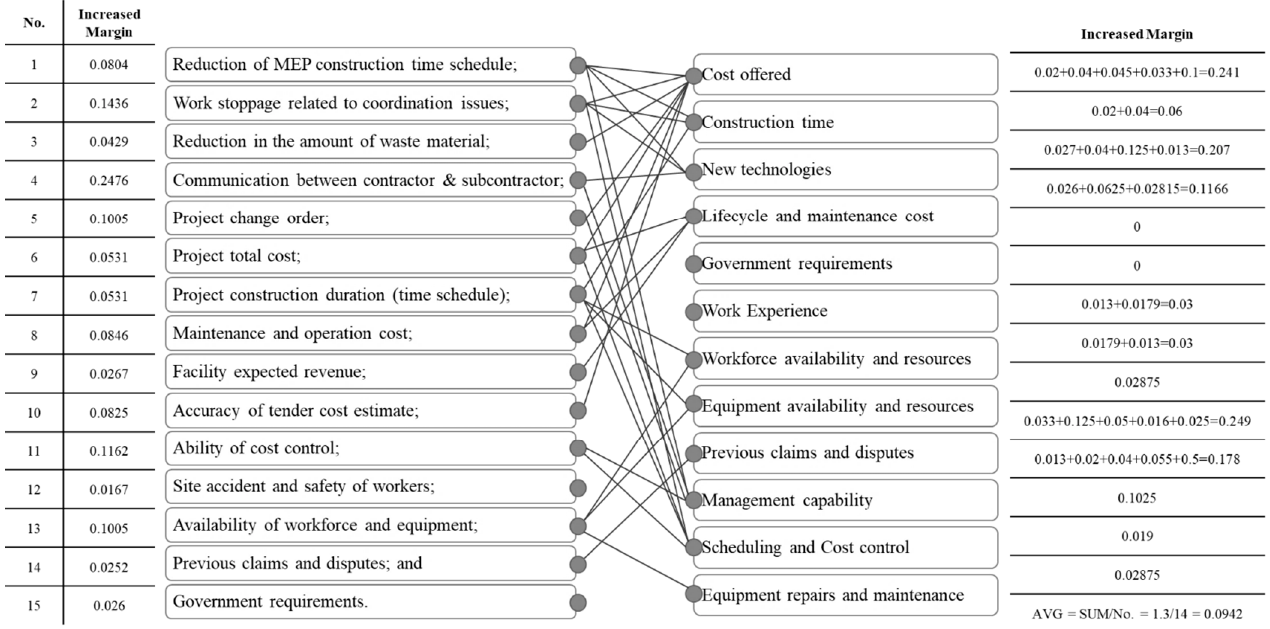
Figure 8. BIM impact on survey criteria calculation process.